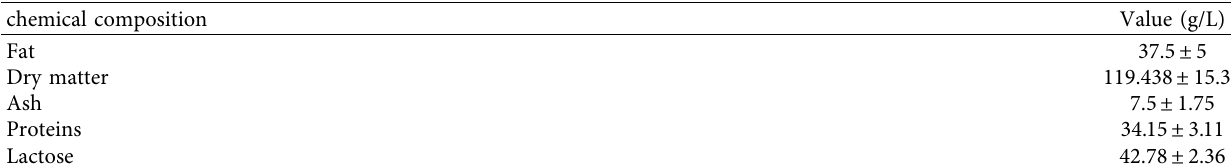
Table 1: Gross composition of camel milk used in this experiment.